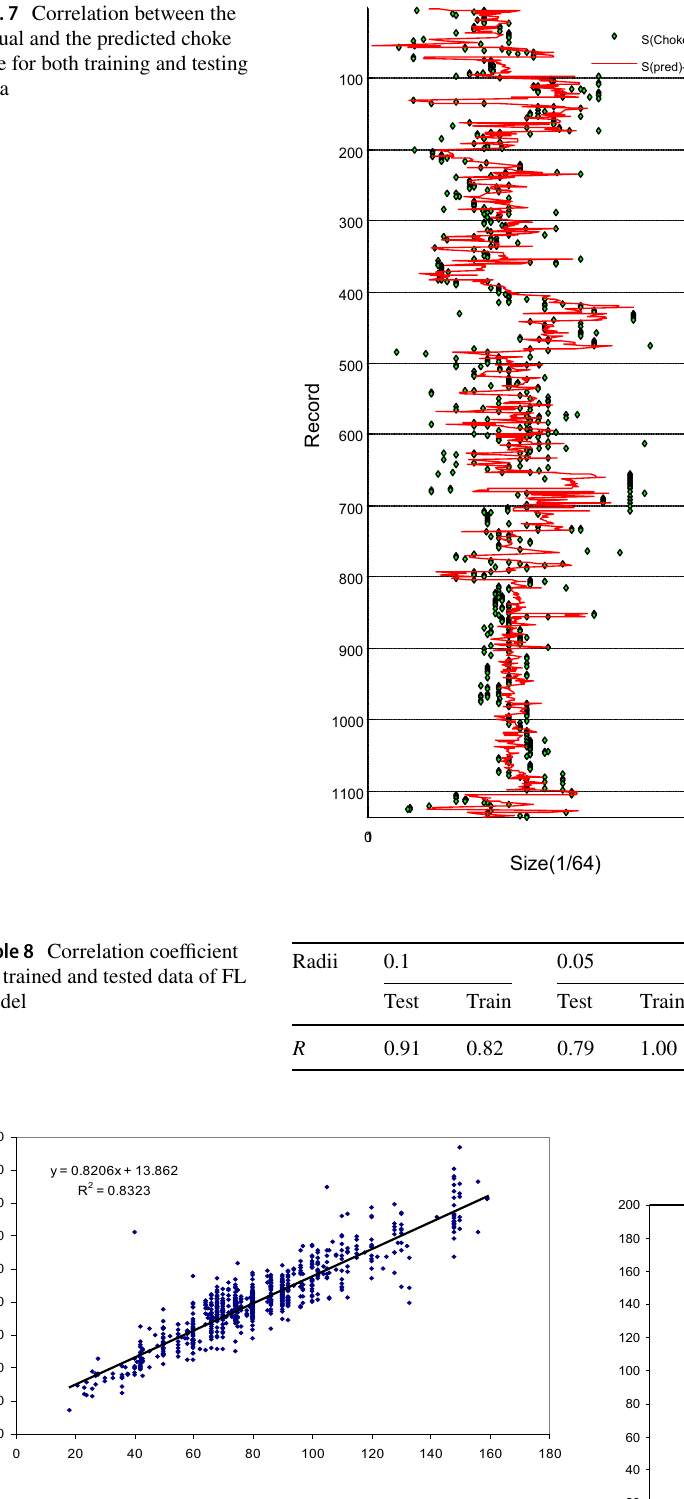
Fig. 7 Correlation between the actual and the predicted choke size for both training and testing data